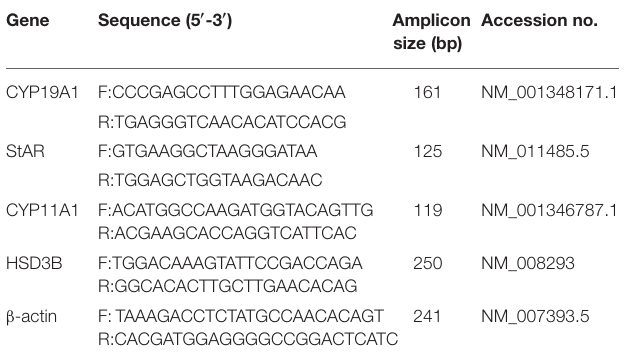
TABLE 2 | Immunization